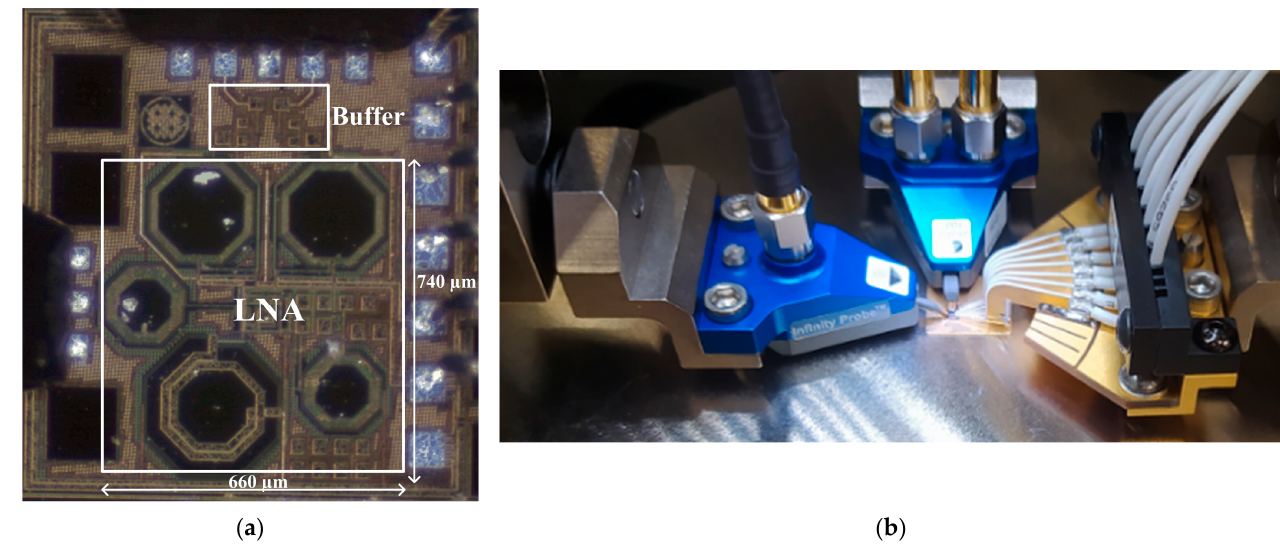
Figure 7. ( a ) Microphotograph of the NB-balun LNA. ( b ) Measurement setup.